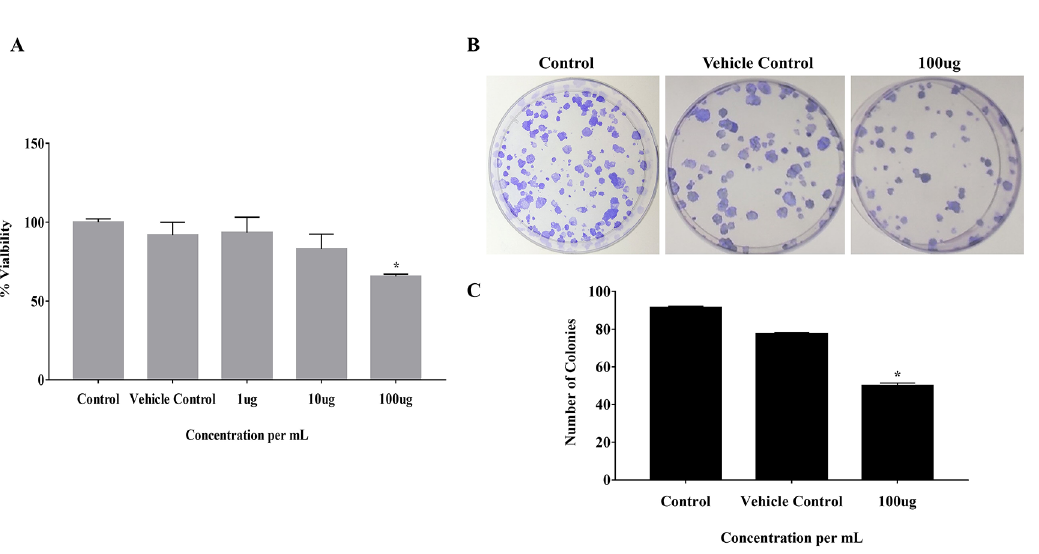
Figure 2. Effect of L. barbarum on cell viability and growth: (A) Cells treated with L. barbarum at different concentrations(1 μ g,10 μ g,and100 μ g)for24hours.AfterincubationwithMTT,absorbancewasmeasuredat 570nm and viability was calculated. Results are expressed as a percentage of viable cells. Data are expressed asmean (cid:1) SDvaluesofthree independentexperiments, withP<0.05. Aconcentration- dependentdecrease in the cell viability was observed when the CAL-27 cells were treated with different concentrations of L. barbarum for 24 hours. A concentration of 100 μ g of L. barbarum extract inhibited cell proliferation